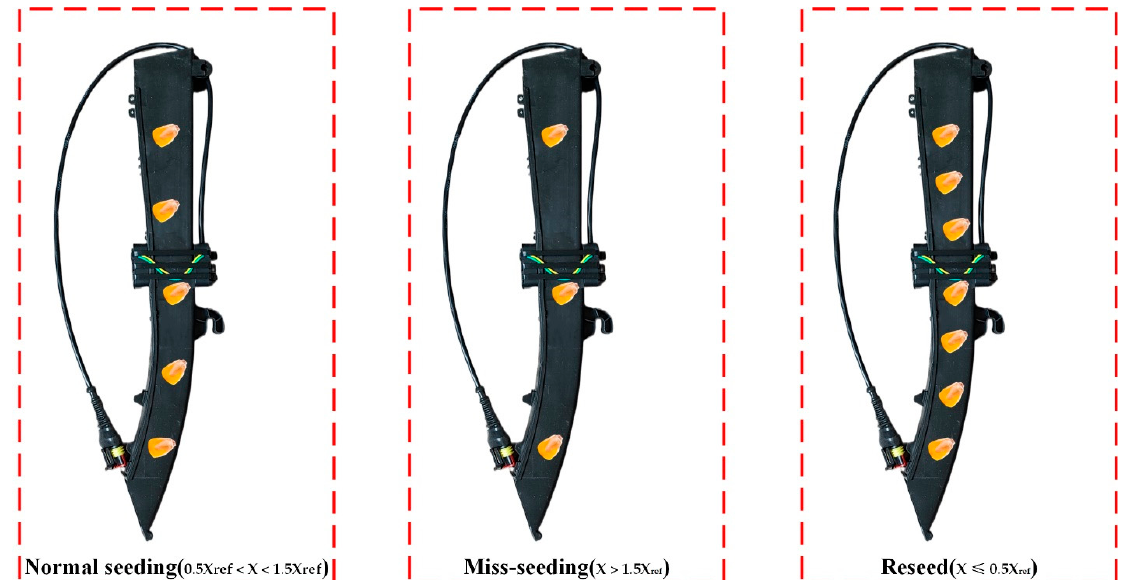
Figure 9. Judging the state of falling seeds in the seed tube.